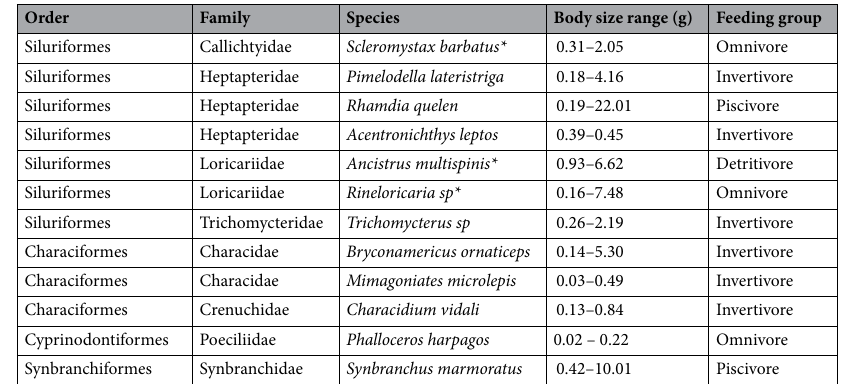
Table 5. List of the studied species with their feeding groups and body size measurements (as estimated by dry weight). *Armored catfish—fish of the family Loricariidae and Callichthyidae, named for the rows of overlapping bony plates that cover and protect their